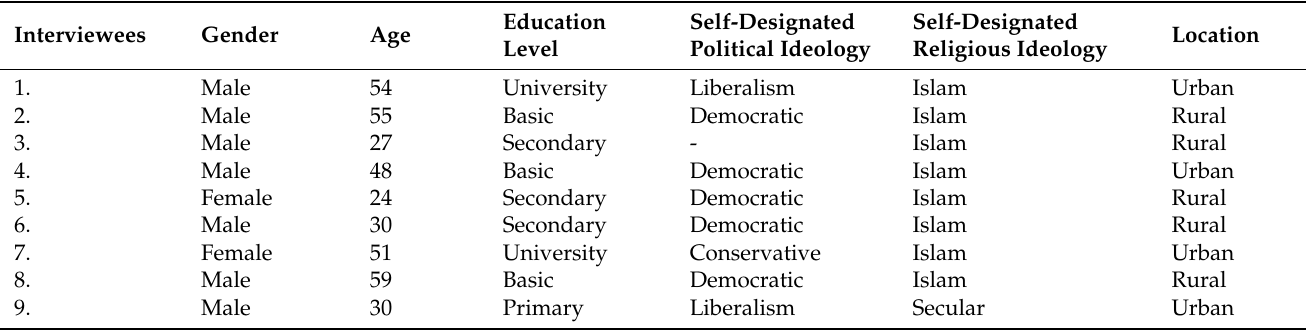
Table 1. Background characteristics of the